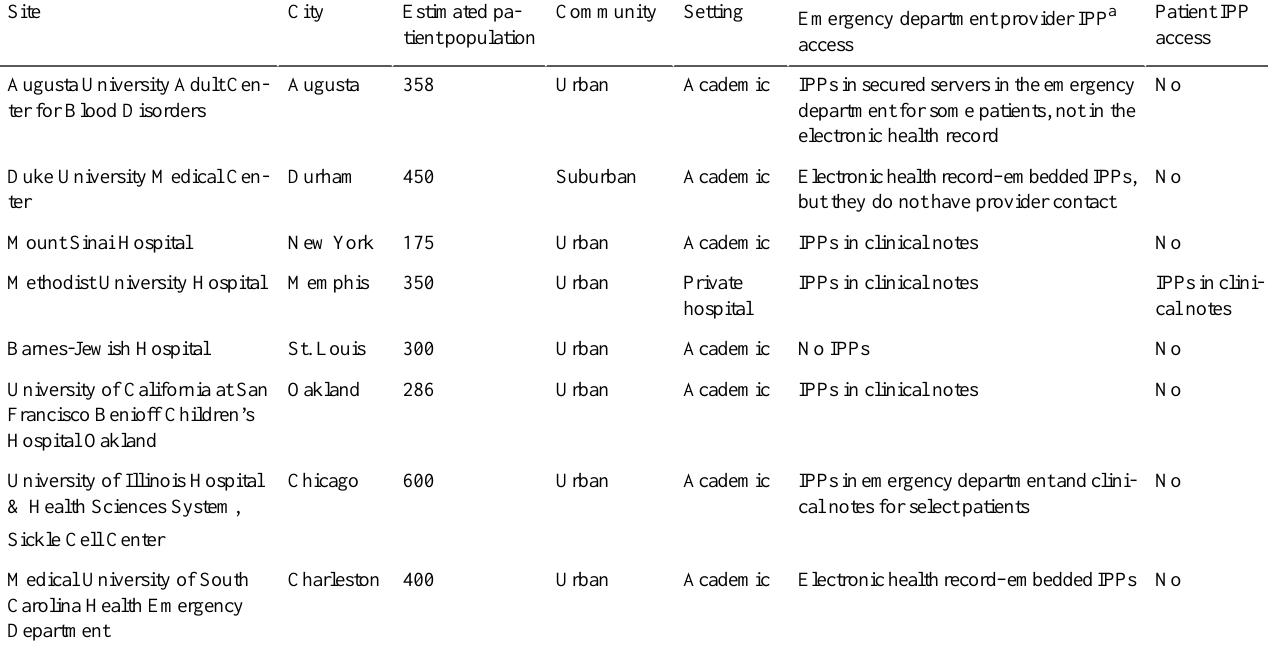
Table 1. Study site characteristics preimplementation.